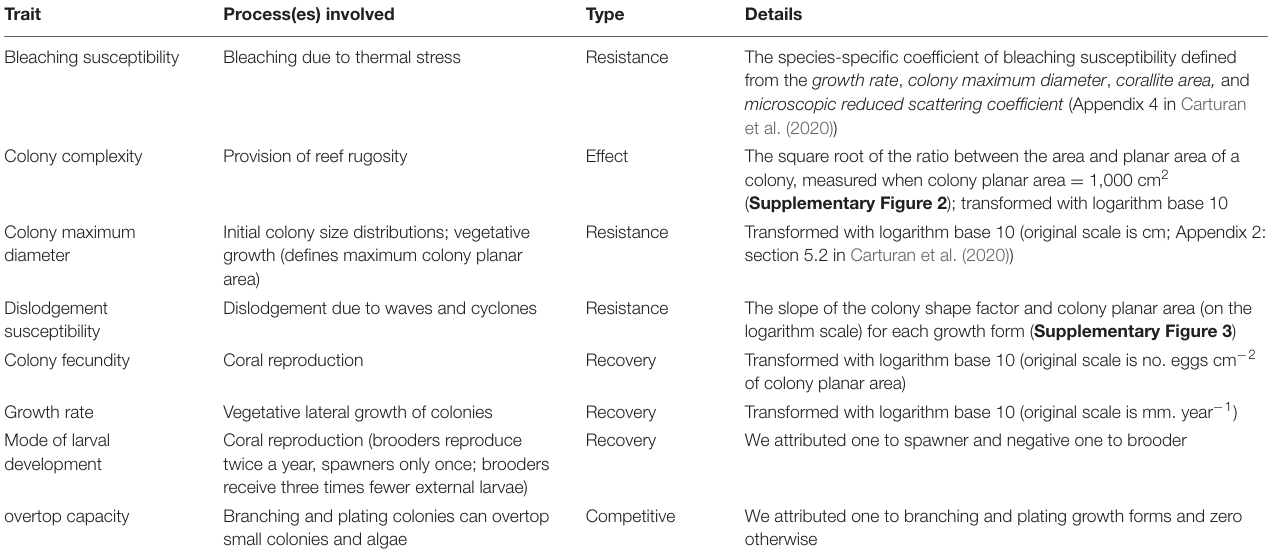
TABLE 1 | The eight functional traits we used to define the functional space.